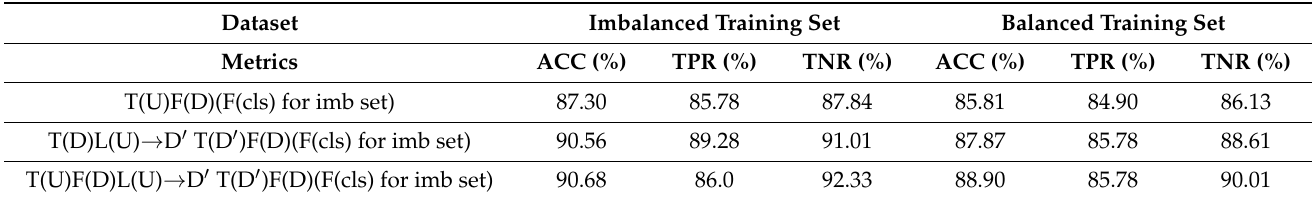
Table 6. Experimental results obtained on Messidor-2 test set (imb set, the imbalanced training set).